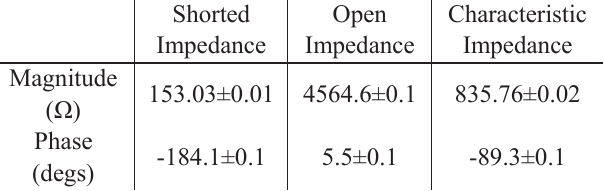
Fig. 7: Fluorescence microscopy images of cells stained with a live-dead assay encapsulated into the alginate